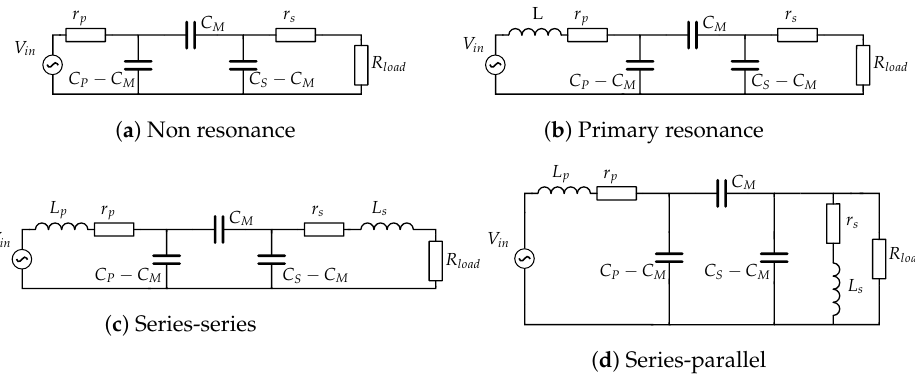
Figure 13. L compensation circuit topologies, with r p and r s the resistive losses within the network.